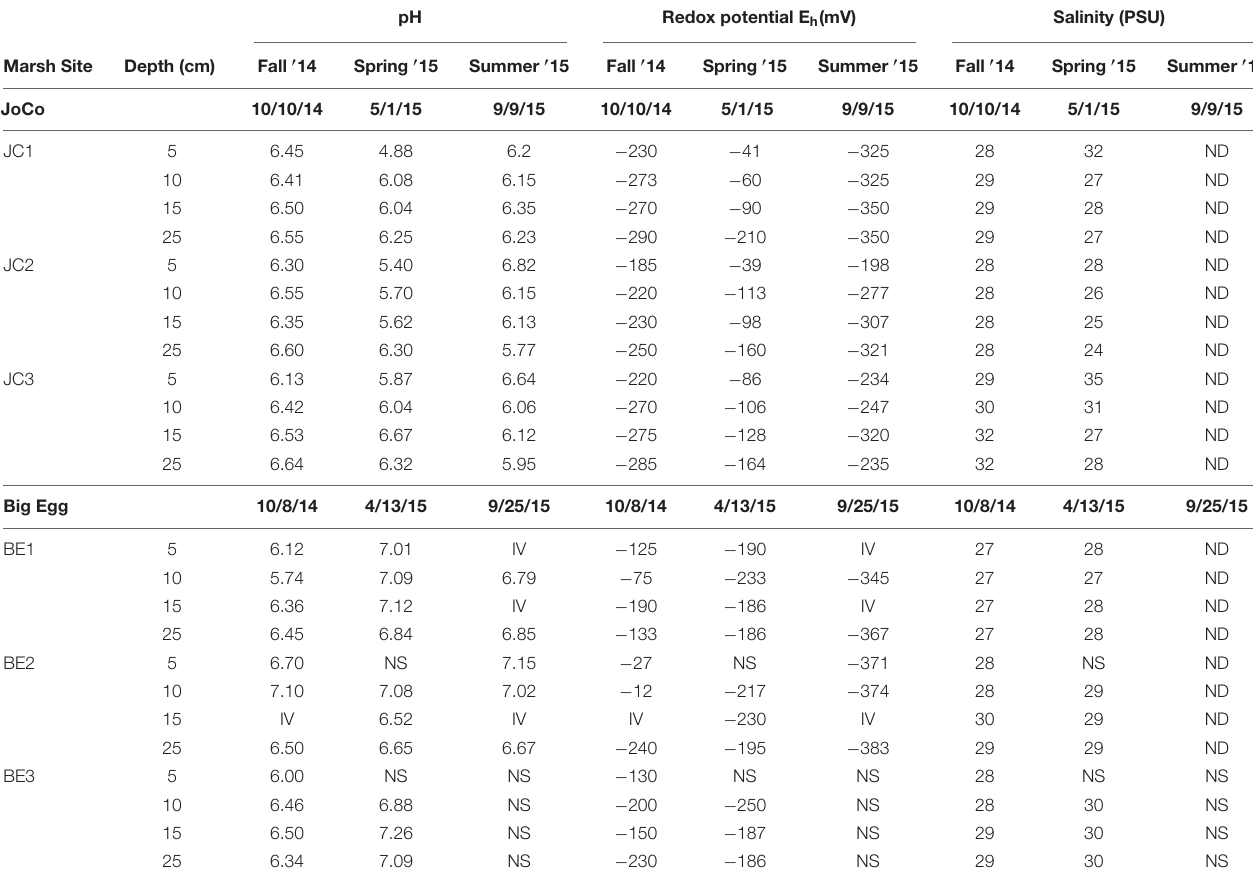
TABLE 1 | Pore water pH, redox potential and salinity data obtained in situ in Big Egg and JoCo marshes, Jamaica Bay, NY. pH Redox potential E h (mV) Salinity (PSU) Marsh Site Depth